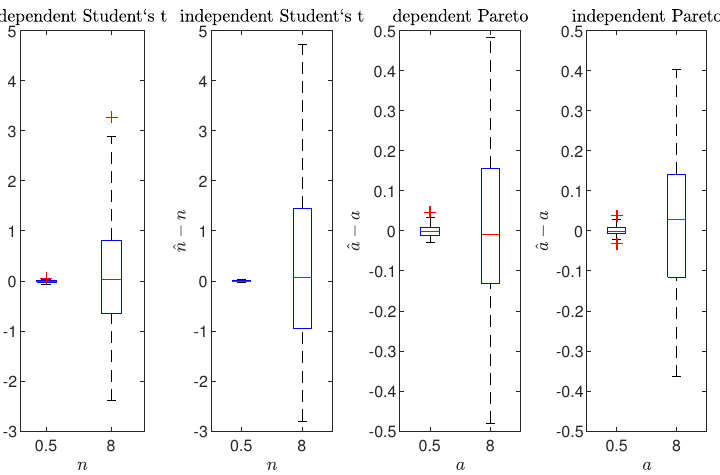
Figure 11. Boxplots of the errors of the degrees of freedom estimator, ˆ n and the tail parameter, ˆ a , for the Student’s t and Pareto distribution products, respectively. ( Left panels ): results for the dependent and independent Student’s t distribution with ρ = 0 and n = 0.5 or n = 8. ( Right panels ): results for the dependent and independent Pareto distribution with θ X = θ Y = 1 and a = a X = a Y = 0.5 or a = a X = a Y = 8. The length of each sample was equal to 1000, while the number of repetitions was equal to